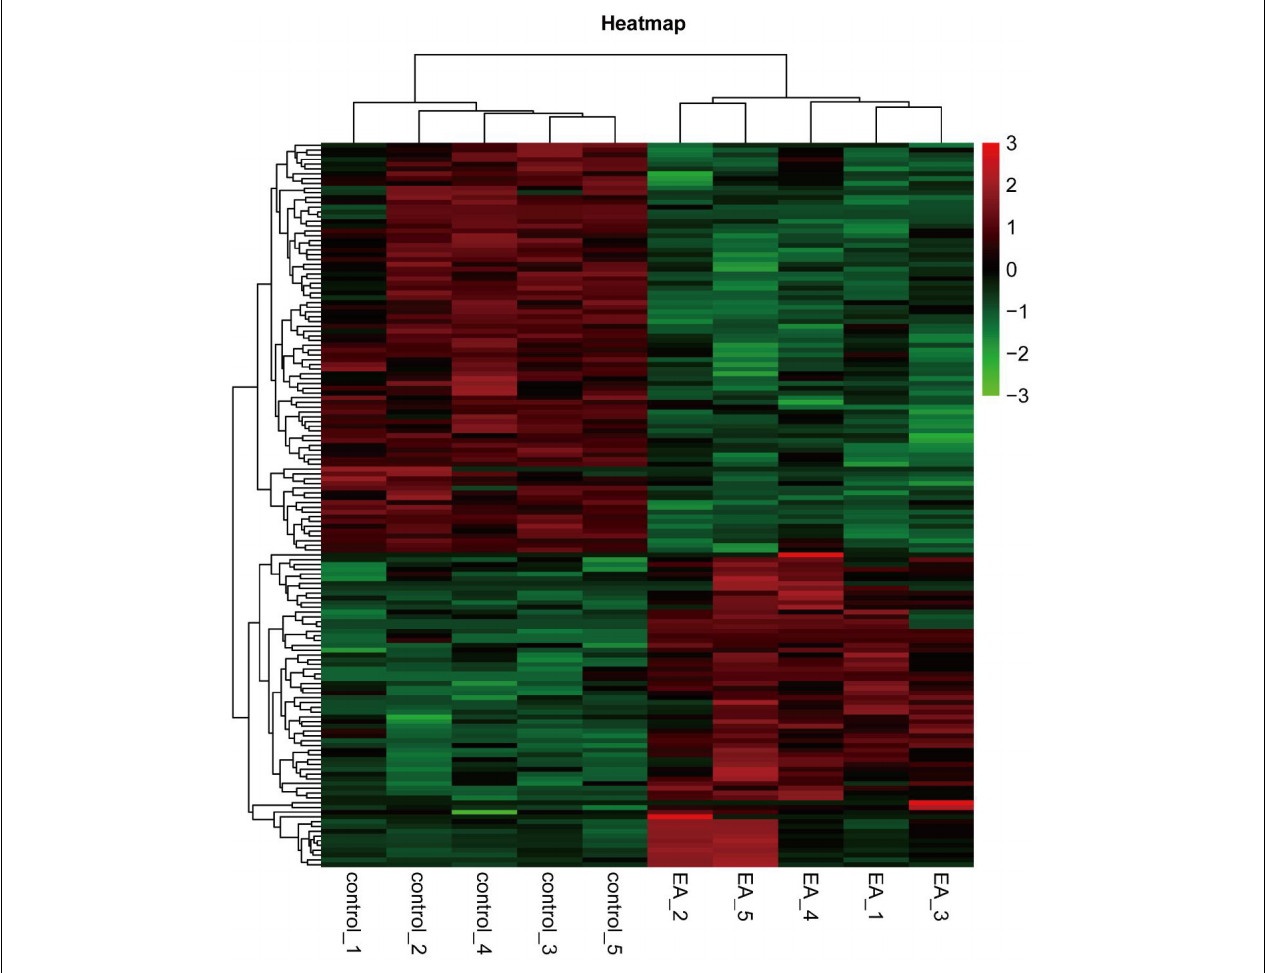
FIGURE 1 | Cluster heatmap of differentially expressed genes.